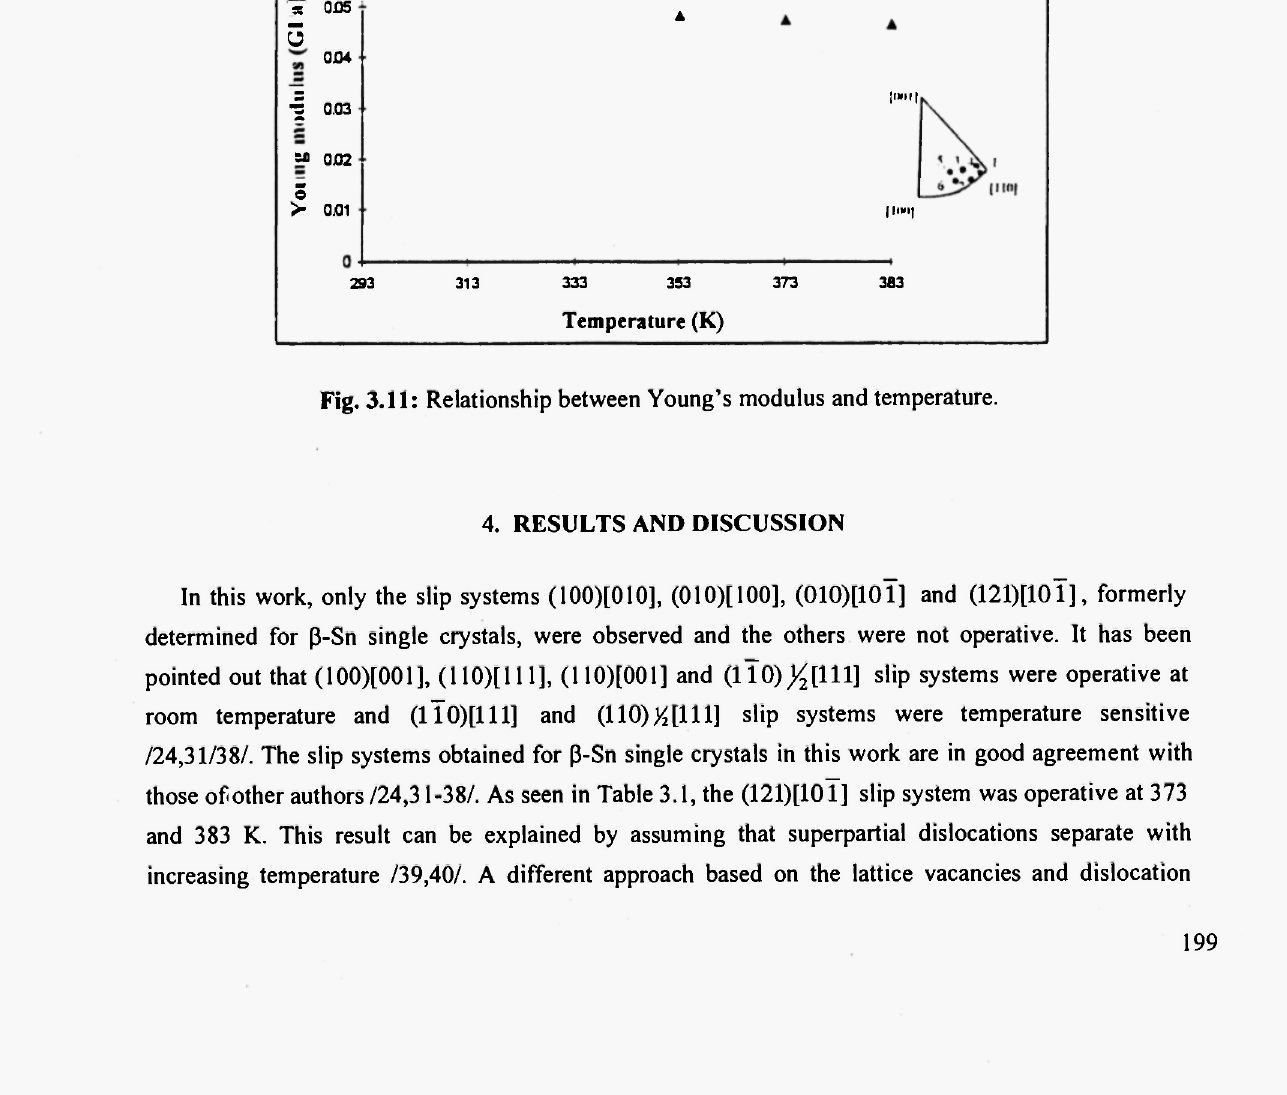
Fig. 3.10: Relationship between fracture, yield elongation and temperature of crystals.